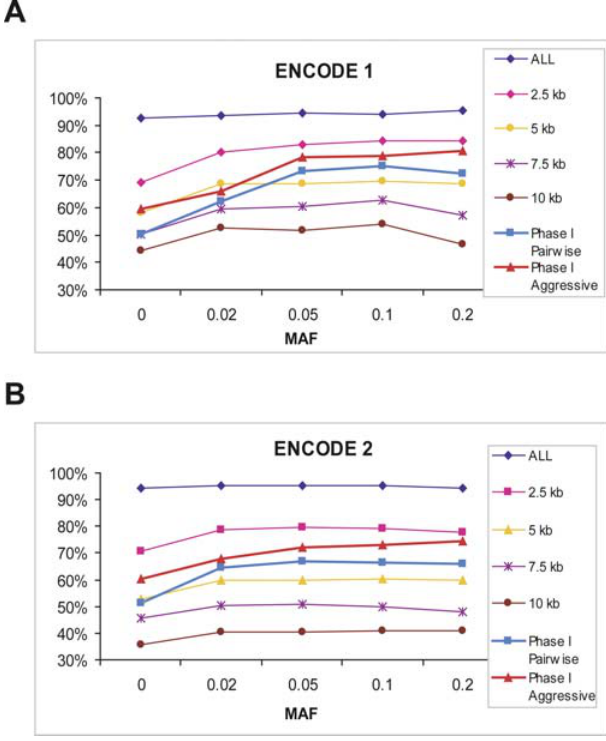
Figure 8. Effect of SNP Density on Tag Selection Tags were selected from the CEU samples using random sets of SNPs averaging the specified densities. The ALL set contains all SNPs and corresponds to a density of one SNP every 1.3 kbp. The Phase I pairwise and aggressive sets contain only SNPs with a minimum MAF of 5% in the CEU sample, and tags were selected with the pairwise and aggressive algorithm of Tagger, respectively. The tagging performance was calculated on the EGP cohort by measuring the ratio of tagged SNPs over all polymorphic SNPs with at least the specified MAF for (A) the ENCODE 1 region and (B) the ENCODE 2 region. DOI: